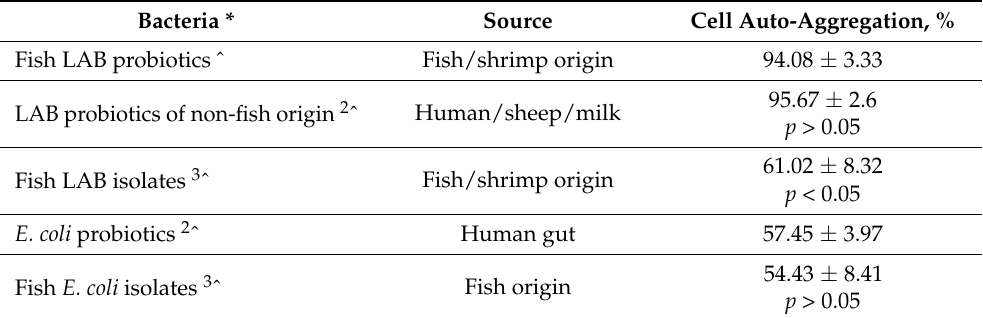
Table 4. Auto-aggregation of lactic acid bacteria and E. coli isolated from the fish gut microbiota, average ± standard deviation.